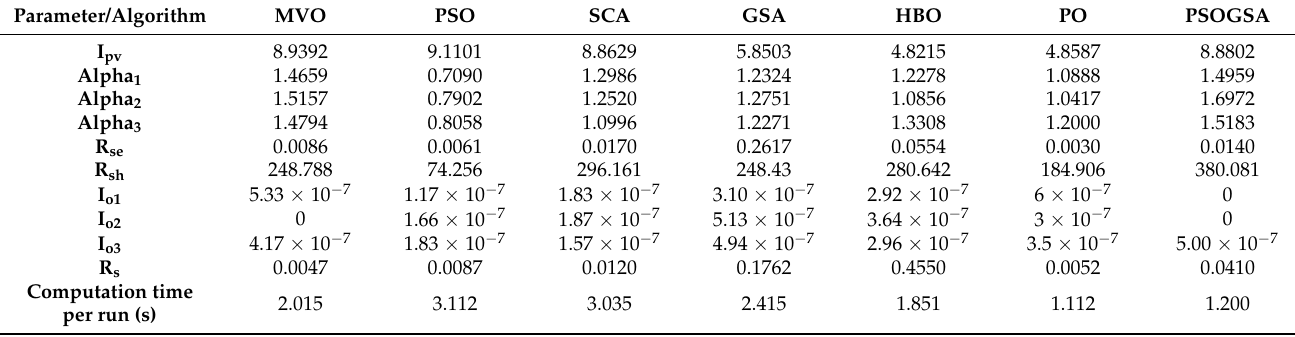
Table 16. Results of parameter estimation of the MTDM for Case